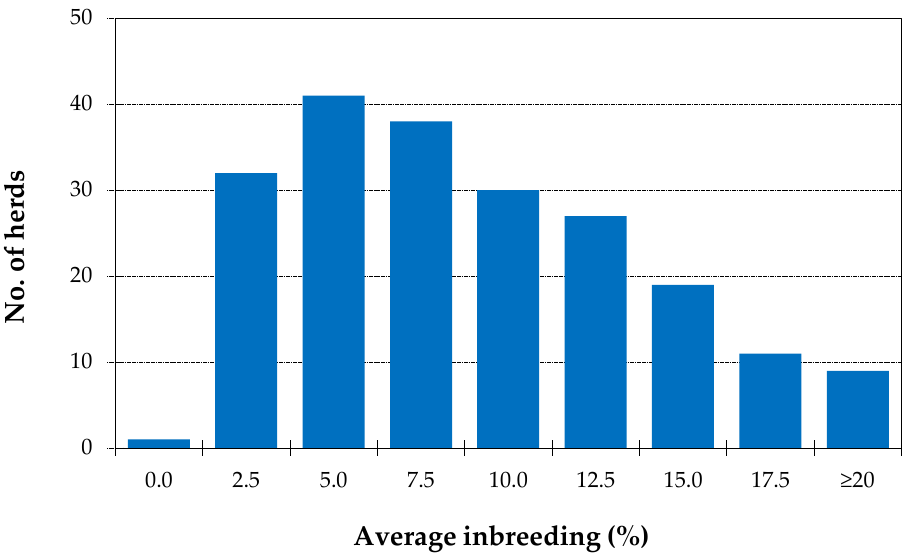
Figure 8. Average inbreeding per herd (only herds with more than 10 calves produced), for calves born from 2015 to 2019.